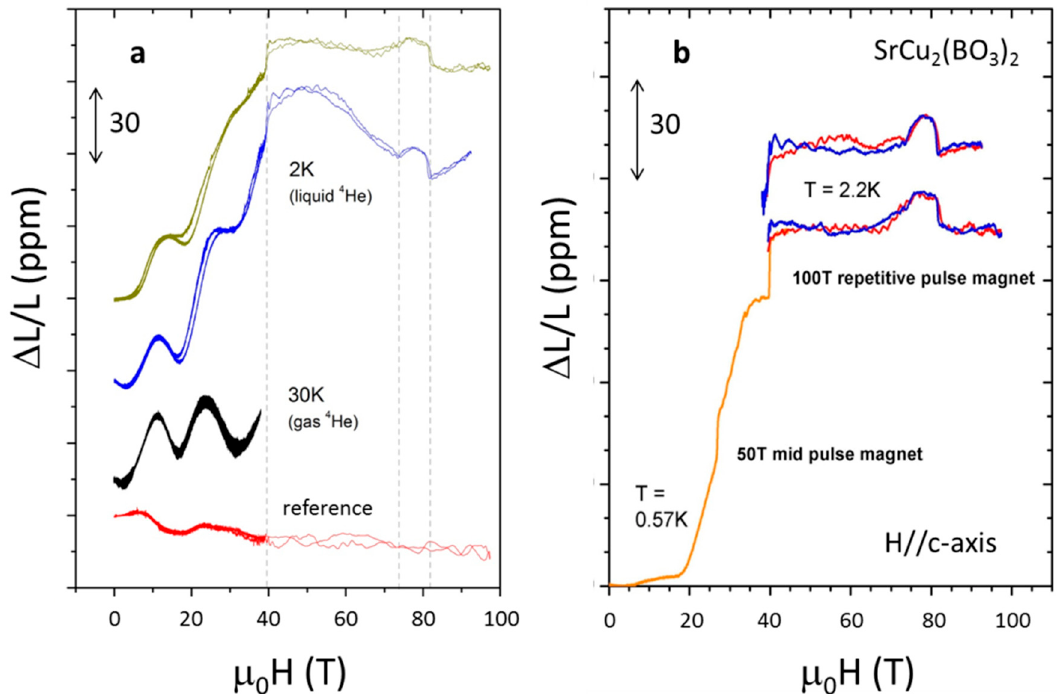
Figure 10. Magnetostriction ∆ L/L vs. magnetic field of a SrCu 2 (BO 3 ) 2 single crystal measured in a 100 T magnet at cryogenic temperatures at the National High Magnetic Field Laboratory at Los Alamos National Laboratory [11]. ( a ) Magnetostriction measurement performed without a polarization scrambler in the experimental setup. The effects of Faraday rotation are evident in the oscillatory nature of data; ( b ) Magnetostriction data composed of results obtained in two different magnets, the 50 T mid pulse magnet for H < 45 T and the 100 T magnet for 35 < H < 97 T, after correcting for the effects of Faraday rotation. Red line is magnetic field up sweep, blue line is magnetic field down sweep.